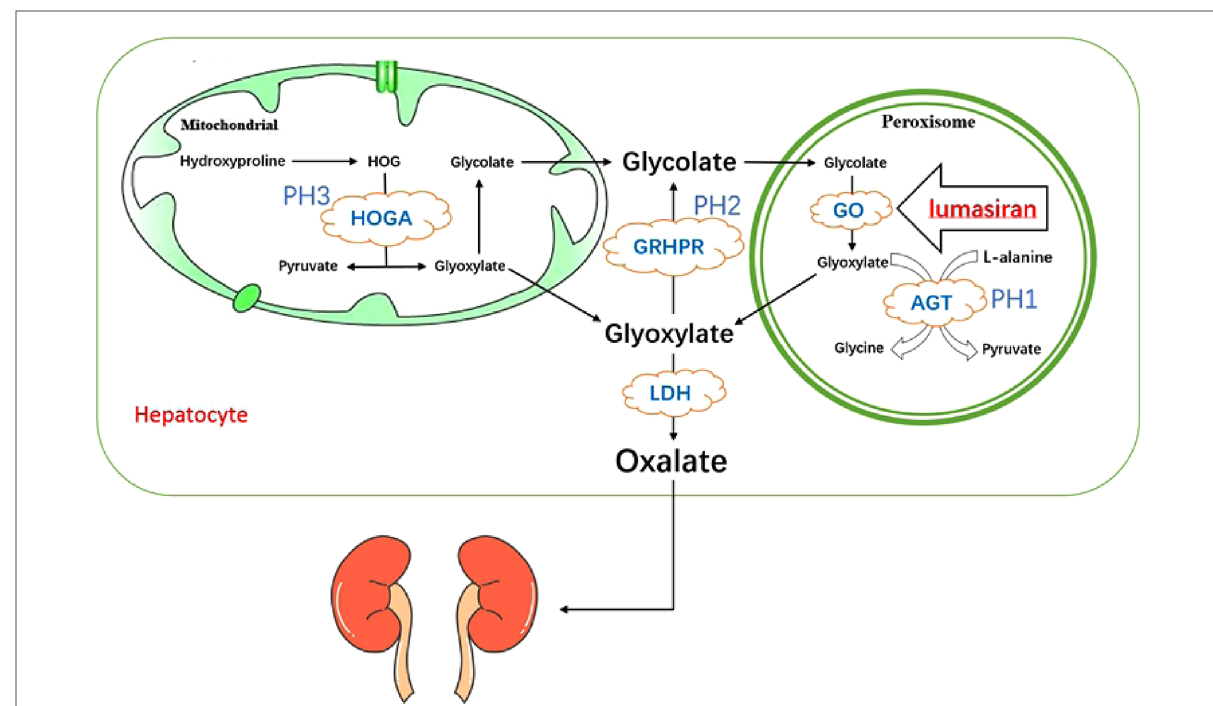
FIGURE 1 Pathogenesis of primary hyperoxaluria type 1 and the mechanism action of lumasiran. HOGA, 4-hydroxy-2-oxoglutarate aldolase; GRHPR, glyoxylate reductase/hydroxypyruvate reductase; AGT, alanine:glyoxylate aminotransferase; GO, glycolate oxidase; LDH, lactate